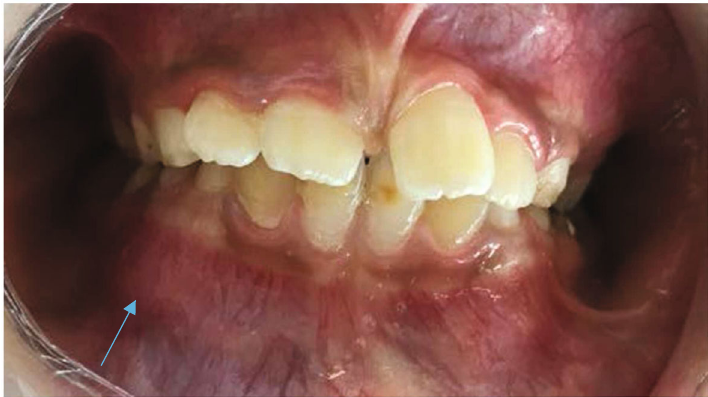
Figure 2: Intraoral view showing buccal hard swelling (blue arrow).